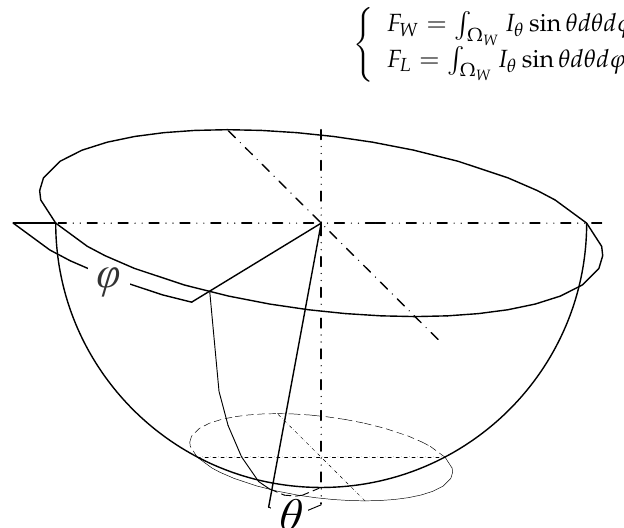
Figure A1. Symbolic schematic diagram.